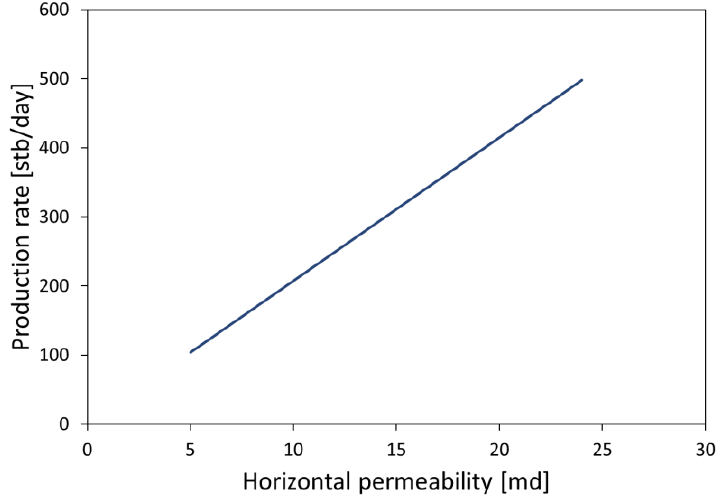
ff ect of horizontal permeability on well production rate (Well Figure 14. Modeled effect of horizontal permeability on well production rate (Well #1). Figure 14. Modeled e